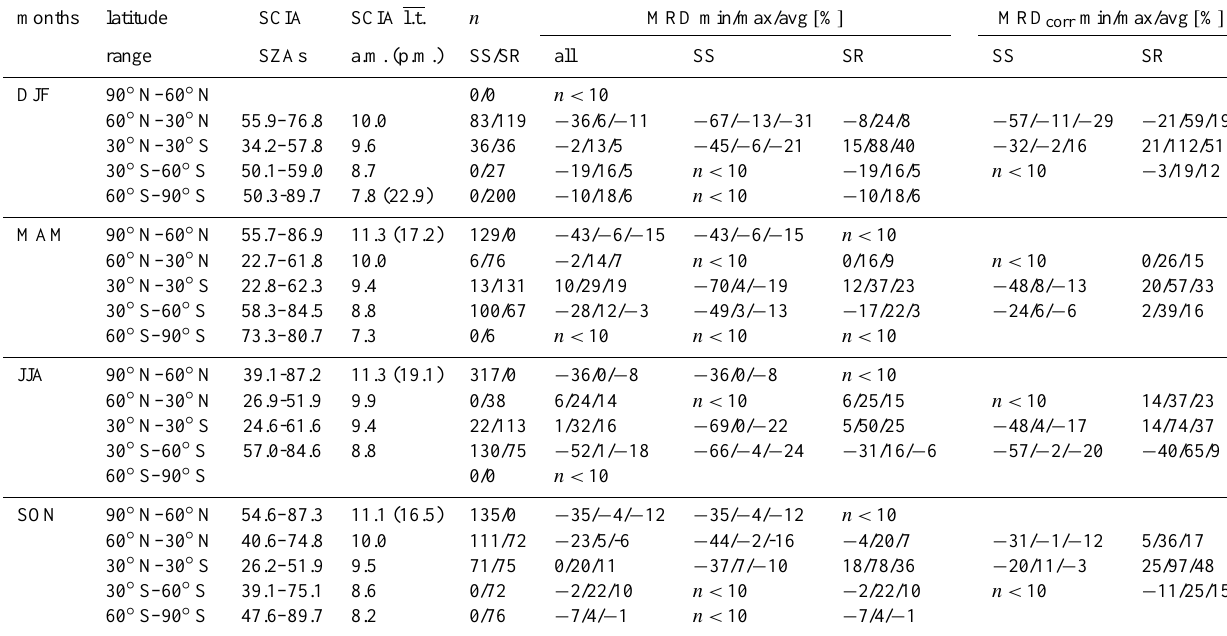
Table 2. Mean relative differences (MRD) for all SAGE II comparisons and for an altitude range from 20 to 40km, respectively. Mean solar zenith angles SZA and mean local times l.t. for SCIAMACHY are given for each bin. MRD corr represents comparisons, where an additional diurnal effect error correction has been applied where appropriate.